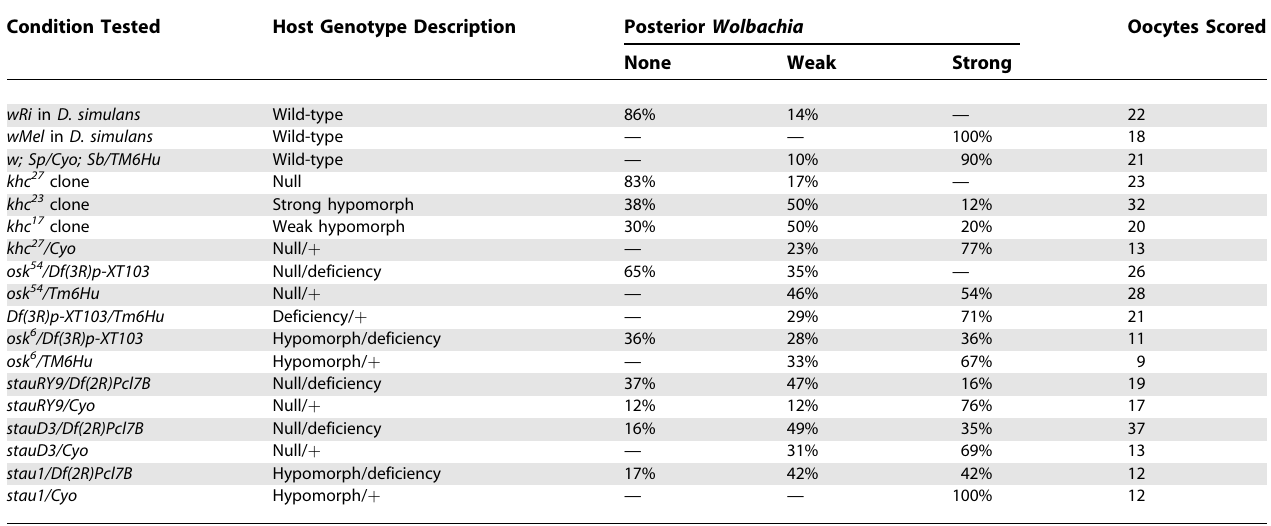
Genotypes represent D. melanogaster unless otherwise indicated. doi:10.1371/journal.ppat.0030190.t001 PLoS Pathogens |